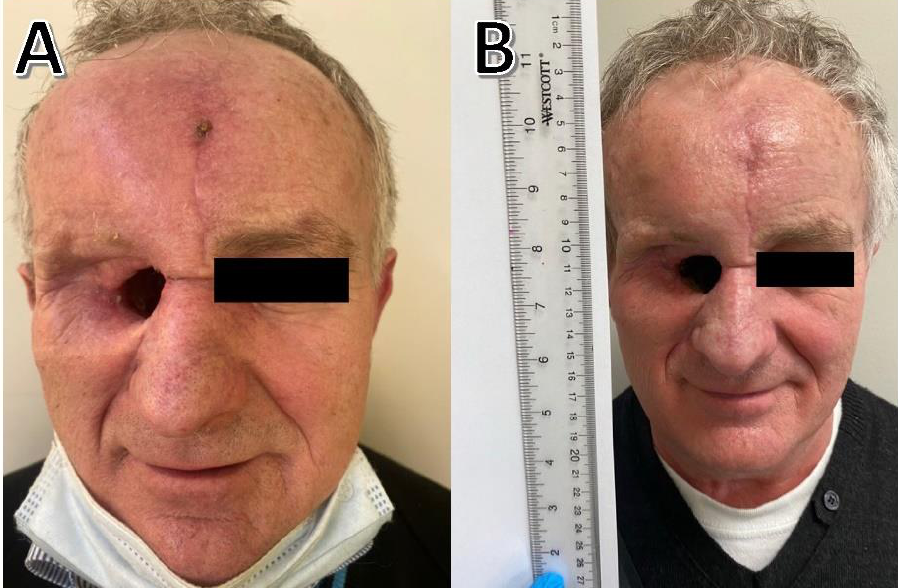
Figure 4. ( A ) Before treatment; small ulceration within the scar where the transplanted skin piece joins the skin of the forehead; ( B ) after 5 weeks of therapy; lesion of the forehead healing .